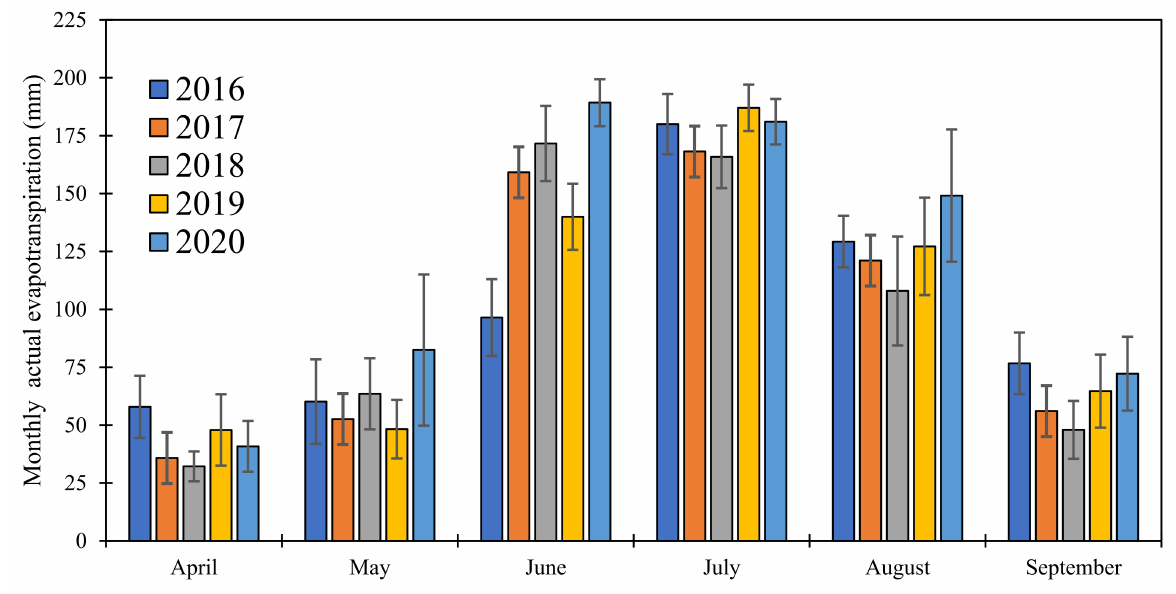
Figure 9. Monthly actual potato crop evapotranspiration with standard deviation among twenty potato fields for the 2016–2020 period under center pivot